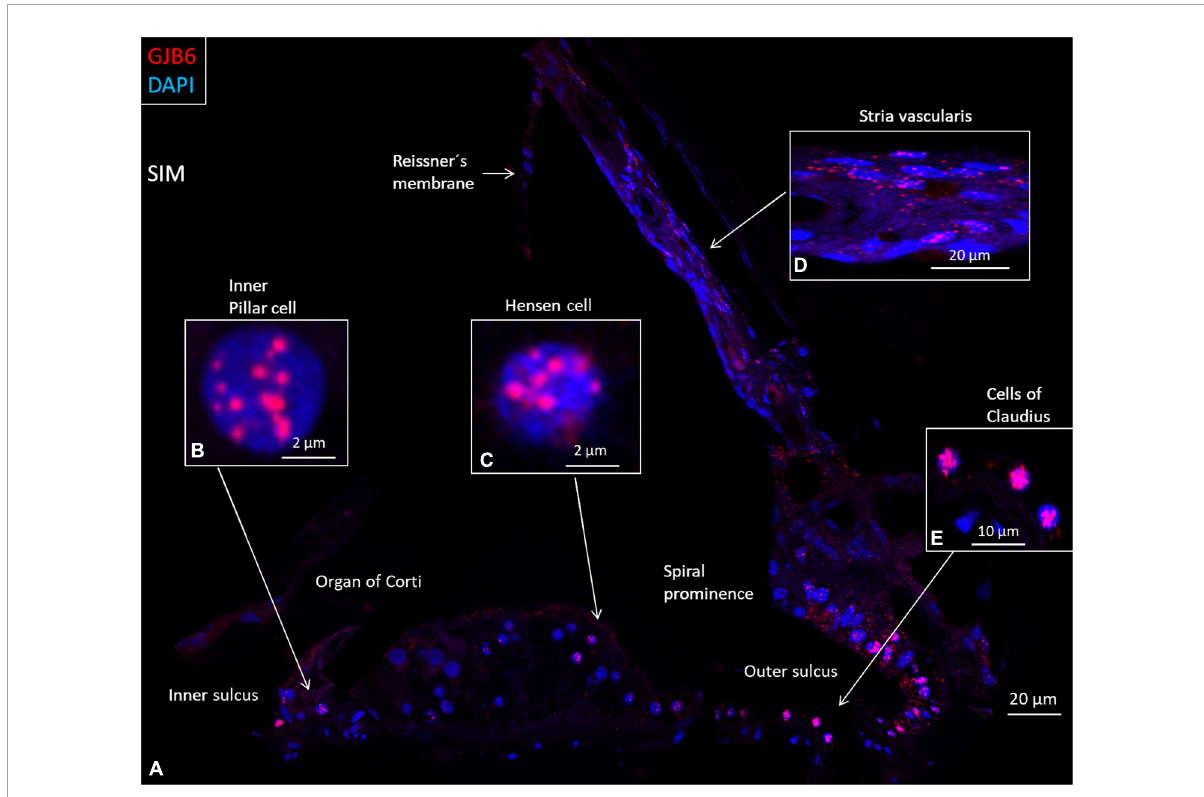
FIGURE7 SR-SIM composite micrograph of GJB6 gene transcripts in the basal turn of the human cochlea. (A) Many GJB6 transcripts are seen in the outer sulcus and type I fibrocytes. Some Claudius cell nuclei contain large numbers of GJB6 gene transcripts. A few supporting cells in the OC contain gene puncta. (B) Higher magnification of an inner pillar cell nucleus contains GJB6 transcripts. (C) Higher magnification of a Hensen cell nucleus contains GJB6 transcripts. (D) Higher magnification shows GJB6 transcripts, mainly in the basal cells. (E) Claudius cells containing many gene transcripts. Cells in the tympanic covering layer contain no gene